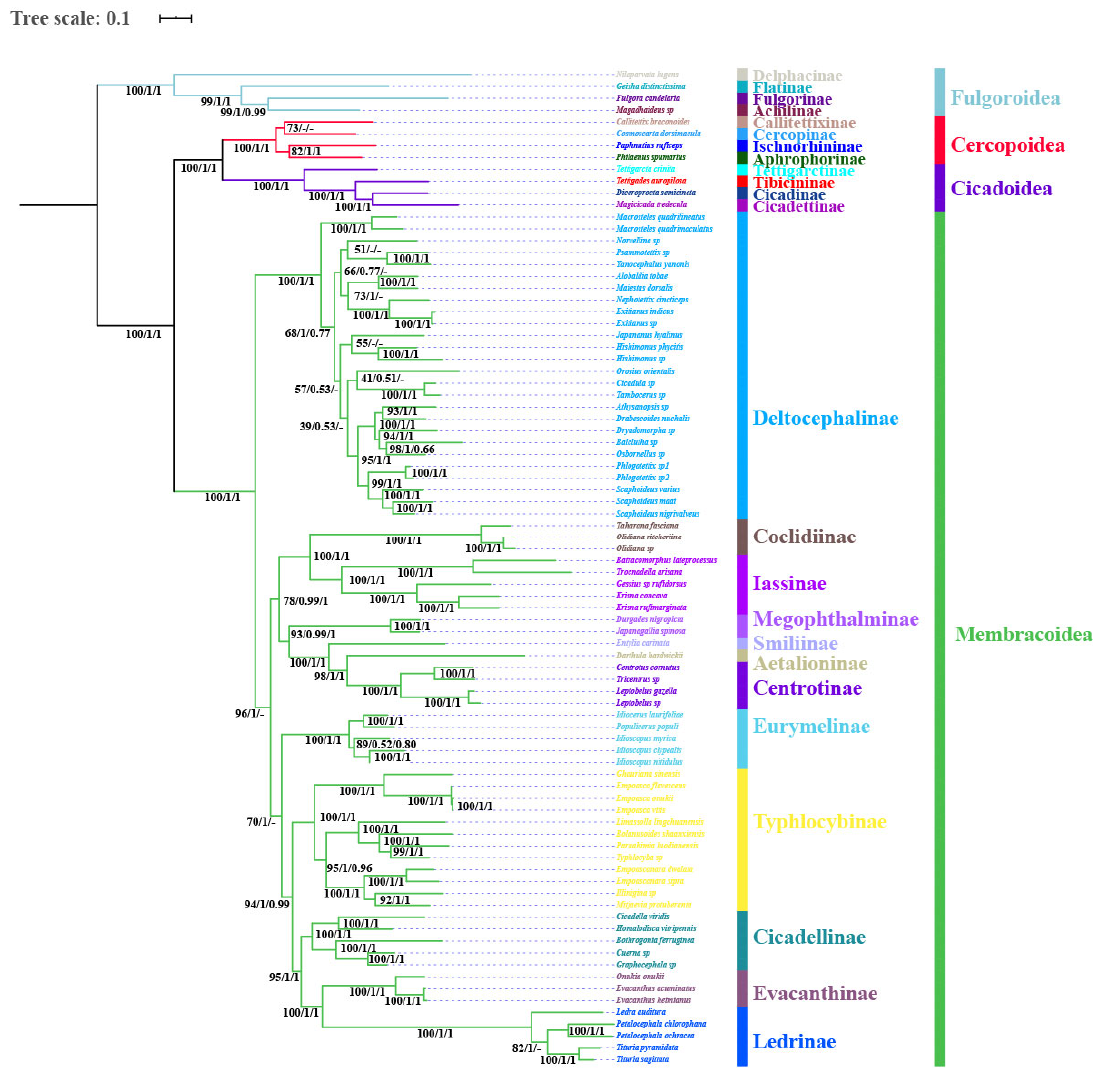
Figure 9. Phylogenetic tree produced using IQtree, Mrbayes and Phylobayes based on the dataset of AA. Numerals at nodes are Bayesian posterior probabilities (PP) and bootstrap support values (BS), respectively. “-” indicates the clades or species are different.